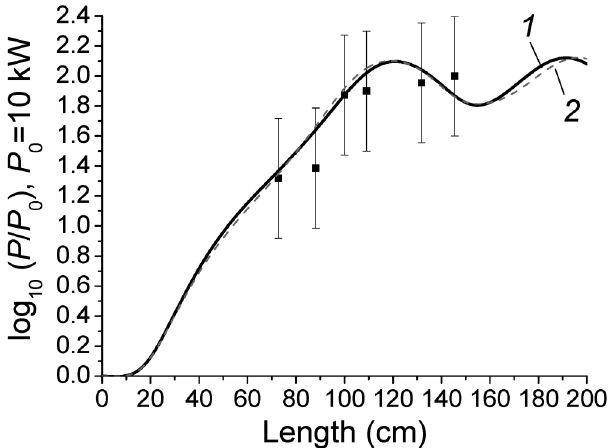
respectively).FIG. versus length: CESTA experimental (vertical lines) and simu- lated (crosses) data [14]; results of simulation for cold beam: 1, from Ref. [22]; 2, by current 1.5D